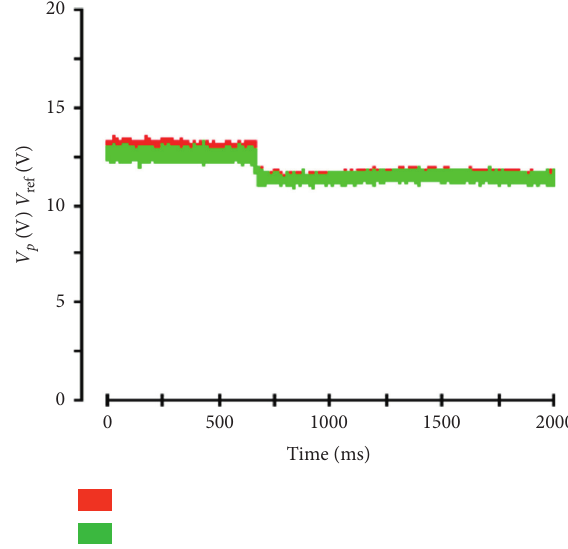
Figure 36: Evolution of optimal and real